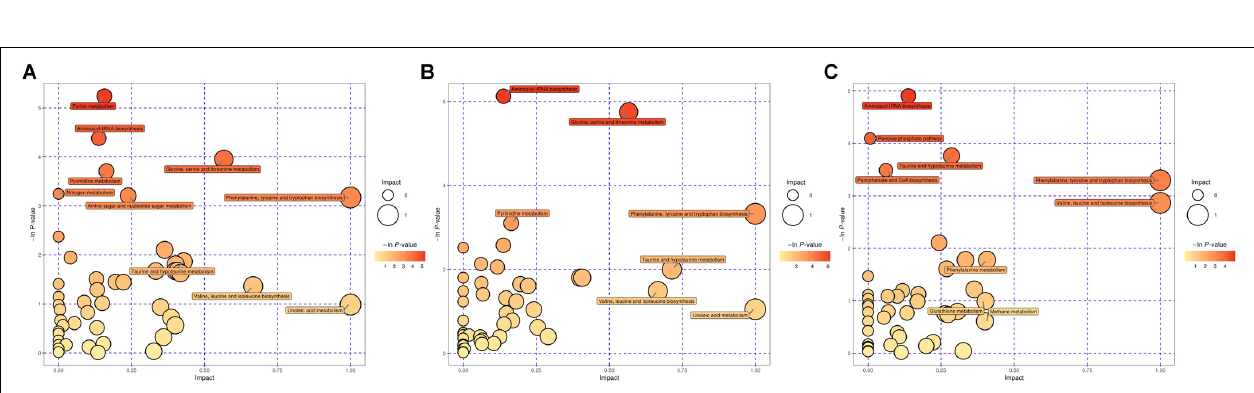
FIGURE 7 | The pathway analysis during C. sinensis infection in ESI+ mode. Plots depict the pathway impacts of the key metabolites ( x -axis) and the computed metabolic pathway as a function of –log (P) ( y -axis) that different between the 4 wpi vs control (A) , 8 wpi vs control (B) , 8 vs 4 wpi (C) .